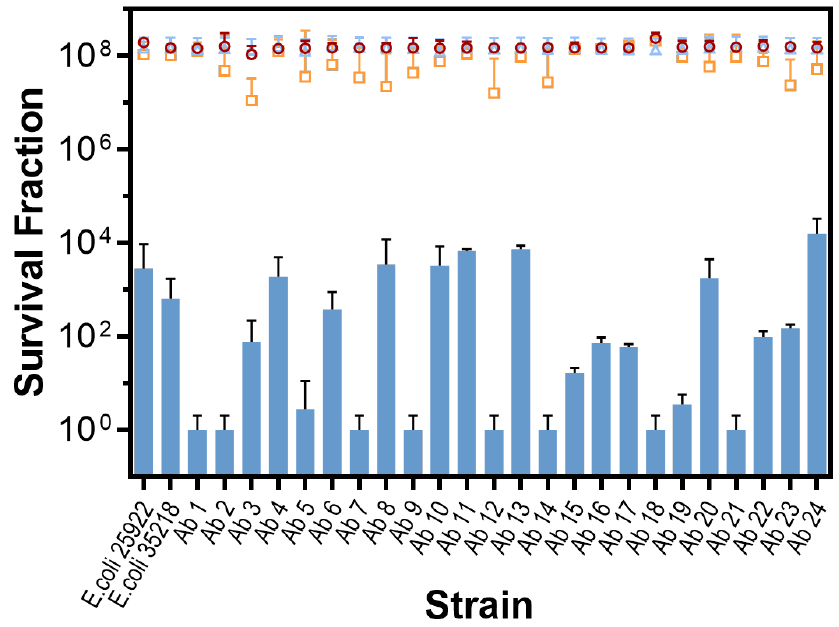
Figure 1. In vitro photodynamic inactivation of E. coli growing in planktonic state (18 J / cm 2 at 625 ± 25 nm, 31 µ M MB concentration). Survival fractions are presented as mean + standard deviation (SD). Circles : cell control (BS1 -L -MB); triangles : light control (BS2 + L -MB); squares : MB control (BS3 -L + MB); bars : test (BS4 + L + MB)